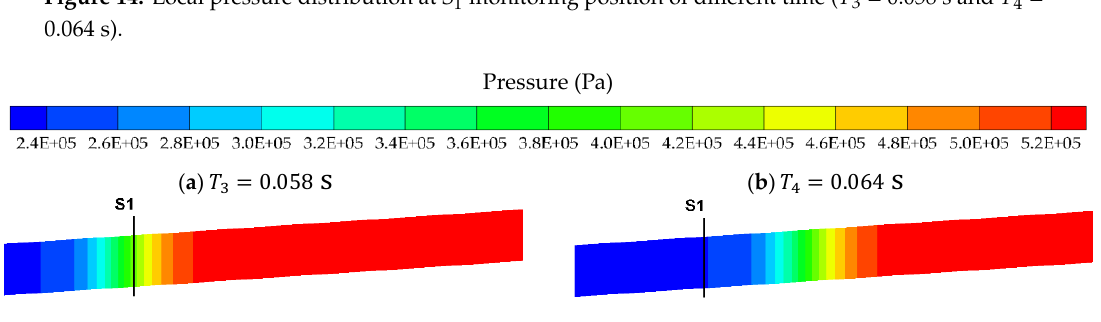
Figure 16. Axial velocity distribution at different time ( 𝑇 5 = 0.092 s , 𝑇 6 = 0.1 s , and 𝑇 7 = 0.108 s ) of the S1 monitoring point.